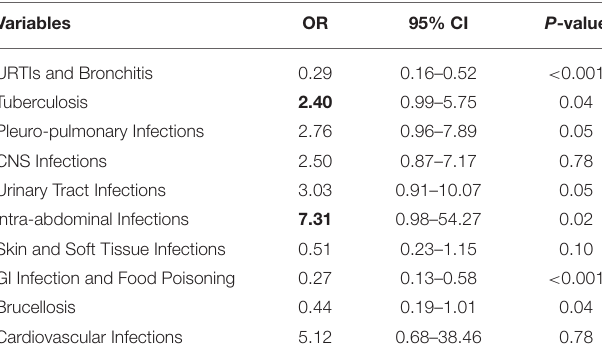
TABLE 4 | The asociation of errors in each category of infectious diseases with major impact on patients’ outcomes (as dependent variable). Variables